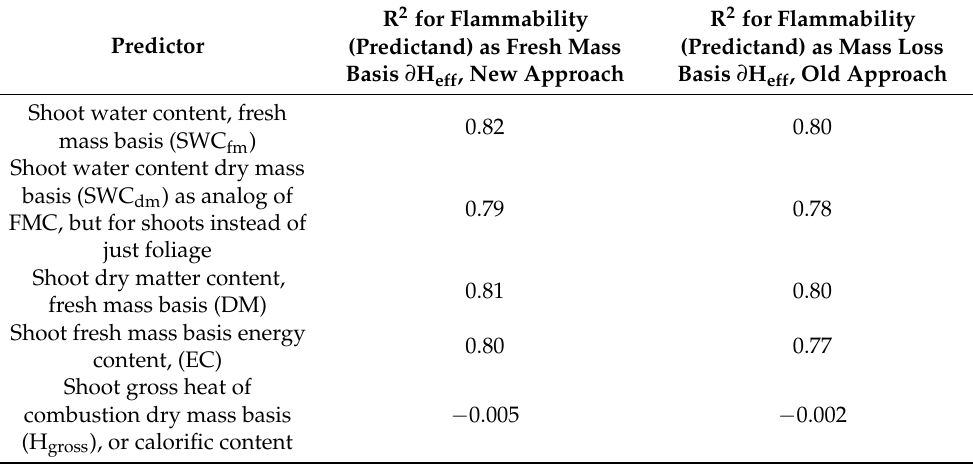
Table 4. Adjusted R-squared values for the predictor variables in modelling flammability as dif- ferential effective heat of combustion on a fresh mass basis ( ∂ H eff ) using traditional and proposed approaches. The proposed fresh mass basis approach introduced in this study showed same or better results in predicting flammability compared with the traditional mass loss basis